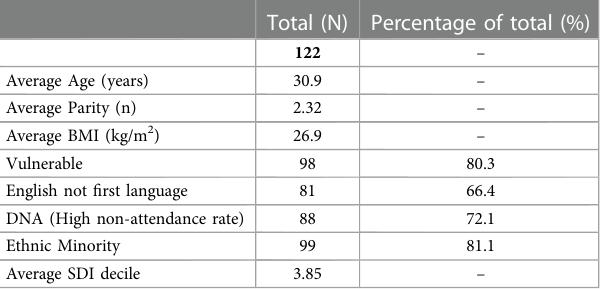
TABLE 2 The sociodemographic characteristics and vulnerability markers for those without a documented reason for MyCare